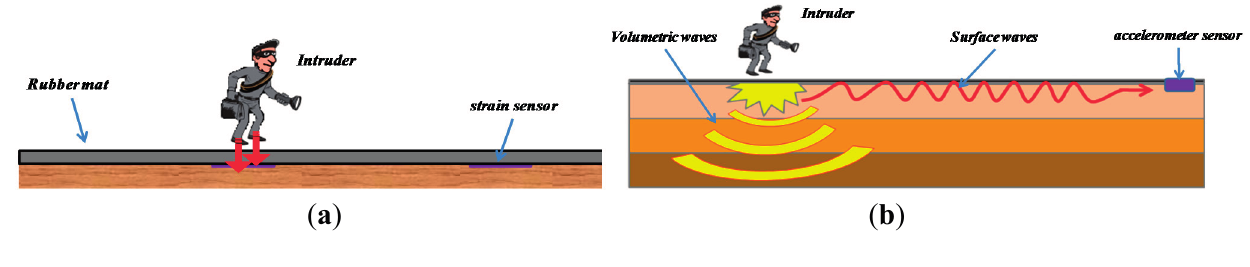
Figure 2. ( a ) Operational principle of the sensorized mat and ( b ) of the accelerometer sensing